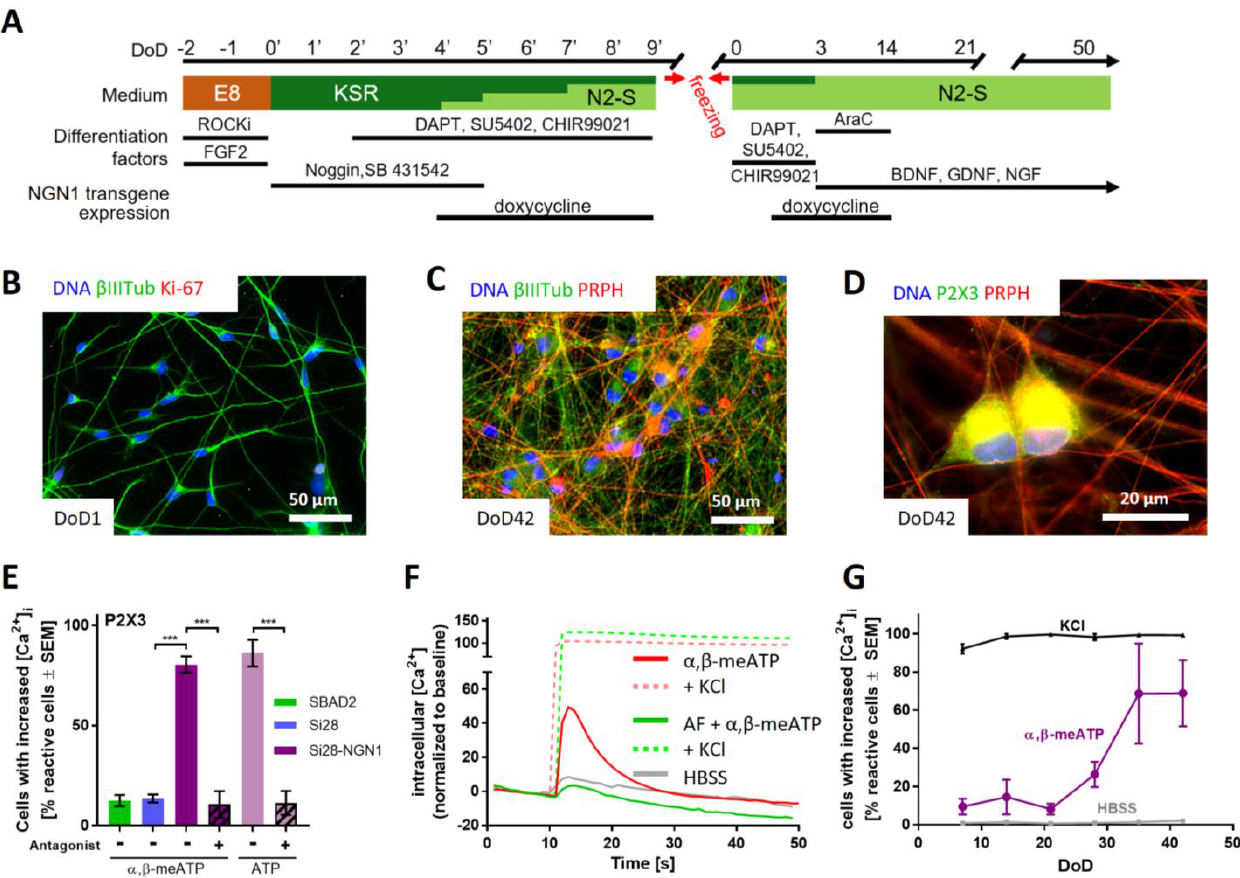
Figure 3. Sensory neurons exhibiting functional P2X3 receptor signaling. ( A ) Schematic representa- tion of the differentiation protocol for the generation of functional sensory neurons from the genetically modified iPSC line Si28-NGN1. During the standard differentiation procedure, transient NGN1 -transgene expression was induced from DoD4’ until DoD9’ and from DoD1 until DoD14 by addition of doxycycline. DoDx’— day of differentiation, counting from pluripotent state (DoD0’); DoDx — day of differentiation, counting from thawing of frozen neural precursors on DoD0. Other factors added (e.g., ROCKi) are detailed in the methods section. ( B – D ) Representative immunoflu- orescence images of cells fixed on DoD1 and stained for ( B ) β III-tubulin ( β IIITub) and the prolifer- ation marker Ki-67 or on DoD42 and stained for ( C ) peripherin (PRPH) and β IIITub or ( D ) P2X3. Nuclei were stained using H33342 (DNA). Color codes and scale bars are given in the images. De- tails are shown in Figure S5. ( E ) Peripheral neurons derived from the iPSC lines SBAD2 (green), Si28 (blue), and Si28-NGN1 (purple) were differentiated for > 38 days and used for Ca 2+ imaging experi- ments. The P2X3-specific agonist α,β -methylene ATP (α,β -meATP) was used to determine the ex- pression of functional P2X3 receptors. ATP was used as a general agonist for purinergic receptors. AF-353, a P2X3-specific antagonist, was used to confirm exclusive P2X3 expression. ( F ) Exemplary traces (red) of changes in intracellular Ca 2+ concentration ([Ca 2+ ] i ) upon α,β -meATP (1 µM) applica- tion (solid lines). After the primary stimulus, KCl (dashed lines) was added. Some cells were pre- treated with AF-353 (0.1 µM) (green). The grey line depicts changes upon application of the negative control (HBSS, grey). ( G ) Time dependency of the expression of functional P2X3 receptors. Sensory neurons were tested weekly for their potential to respond to HBSS, α,β -meATP, and general mem- brane depolarization induced by KCl. ( E , G ) Data are expressed as the mean ± SEM of three inde- pendent biological replicates. ***, p < 0.0001.